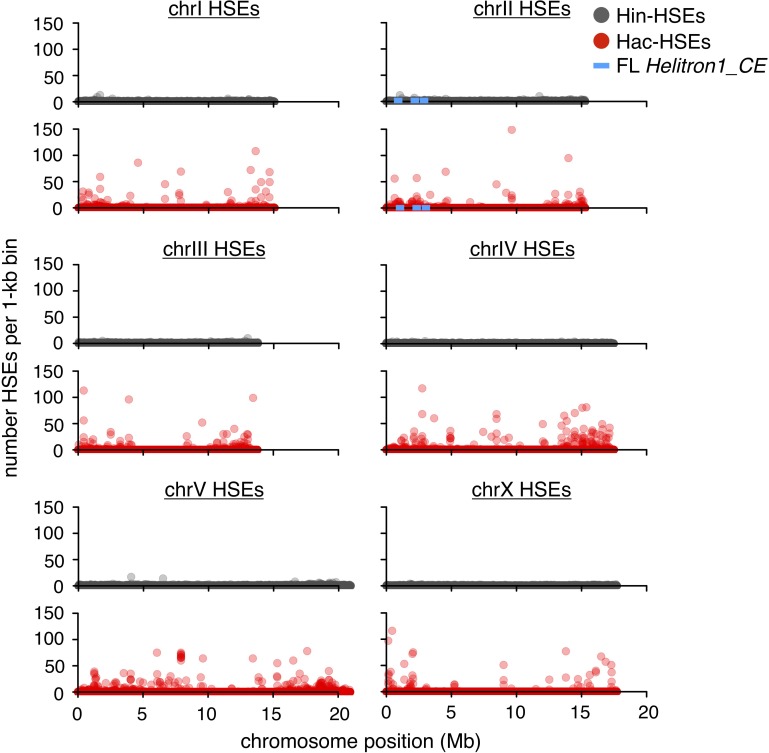
Genome-wide distributions of Hin- and Hac-HSEs.Numbers of Hin- (gray) and Hac-HSEs (red) within 1 kb bins along the length of each C. elegans chromosome. The approximate positions of full-length (FL) Helitron1_CE elements are shown using blue lines.